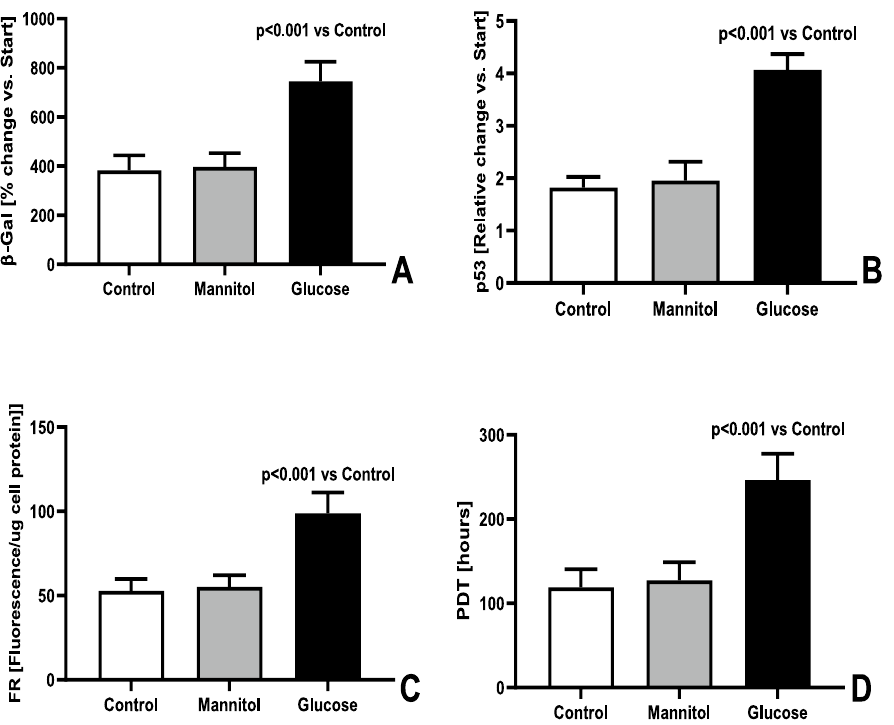
Figure 1. Activity of β-galactosidase ( A ), expression of p53 gene ( B ), intracellular oxidative stress ( C ) and Population doubling time ( D ) in HREC at the end of the replicative senescence in control medium (Control), medium supplemented with Mannitol 20 mmol/L (Mannitol) or medium supplemented with glucose 20 mmol/L (Glucose) (n = 8) (ANOVA